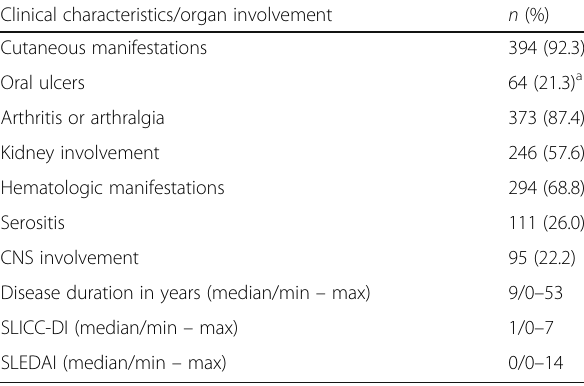
Table 1 Clinical characteristics of systemic lupus erythematosus patients ( n = 427) Clinical characteristics/organ involvement n (%) Cutaneous manifestations